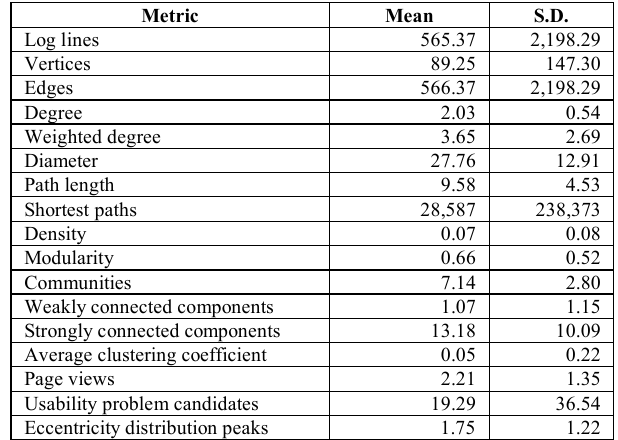
TABLE I. S UMMARY OF THE 427 USAGE GRAPHS ANALYZED .